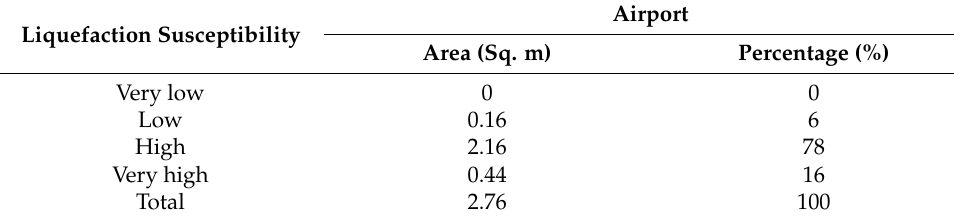
Table 4. Liquefaction susceptibility of Tribhuvan International Airport in Kathmandu Valley. Liquefaction Susceptibility